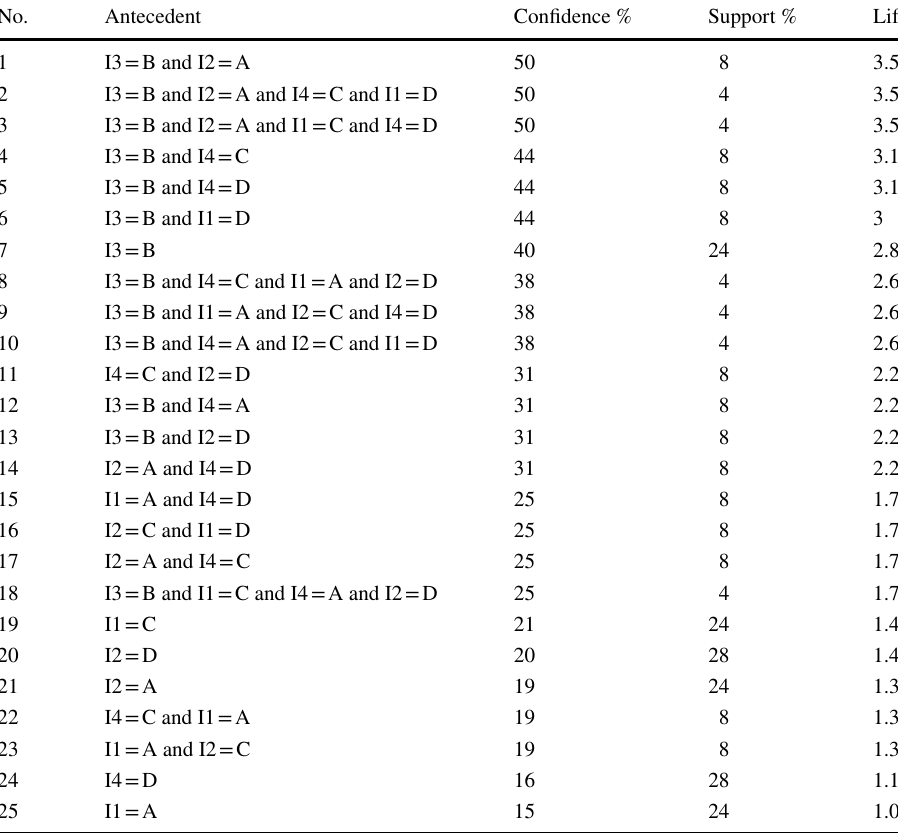
Table 19 The rules extracted No. Antecedent Confidence % Support % between cluster fifth as the consequent and irrigation amounts in different stages of growth as the antecedent